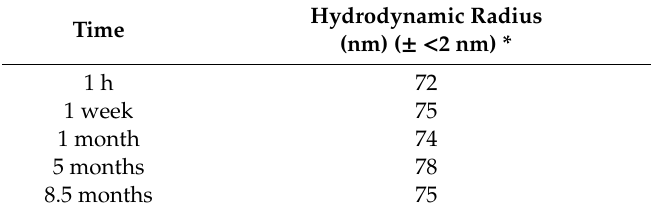
Table 1. Temporal stability of vesicles by dynamic light scattering (DLS).